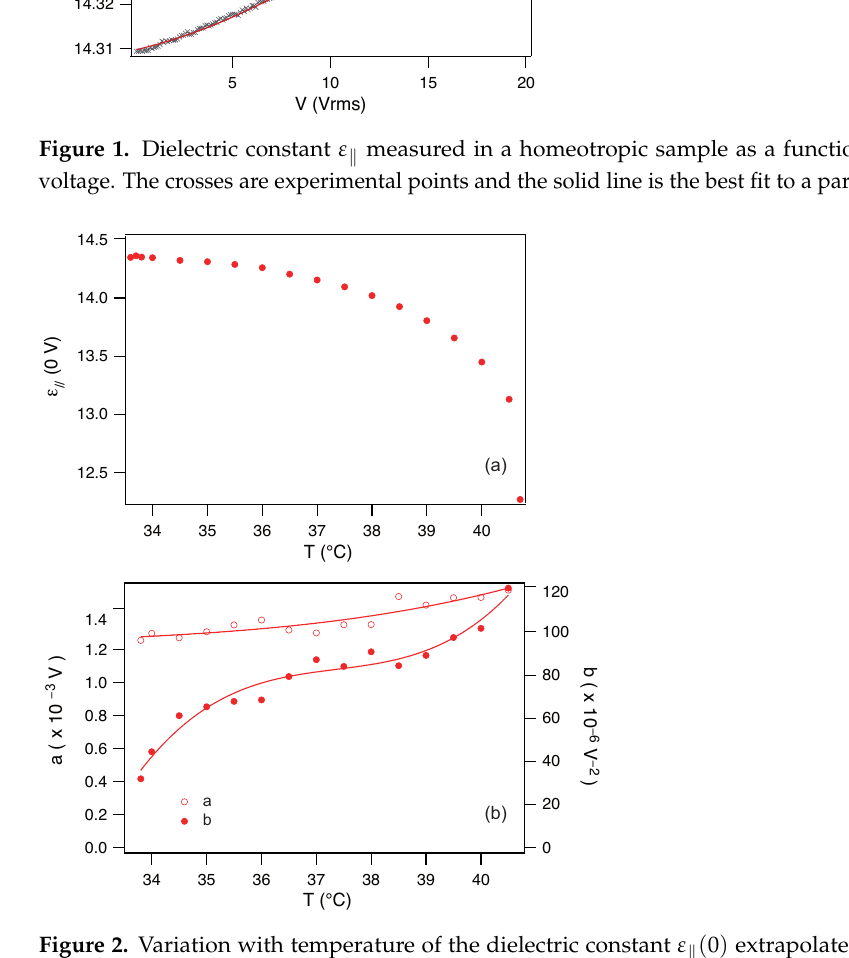
Figure 2. Variation with temperature of the dielectric constant ε (cid:107) ( 0 ) extrapolated at zero voltage ( a ) and of the fit parameters a and b ( b ). The solid lines are just guides for the eye.